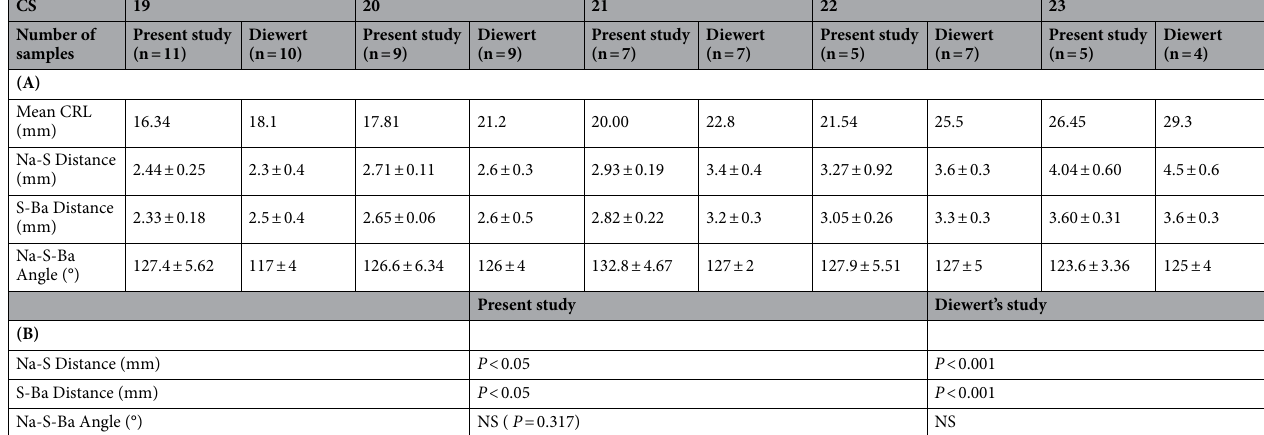
Table 4. Measurements of the cranial base in sagittal sections of human embryos during the late embryonic period. (A) Mean ± standard deviation (SD) for Diewert’s and our studies are presented in this table. Each value of Diewert’s study was obtained by dividing the original value by 36 (see Materials and methods ). (B) Significant differences between stages were calculated using the F-test of the analysis of variance. A P -value greater than 0.05 was defined as nonsignificant (NS). CS Carnegie stage, CRL crown-rump length, Na nasion, S sella, Ba